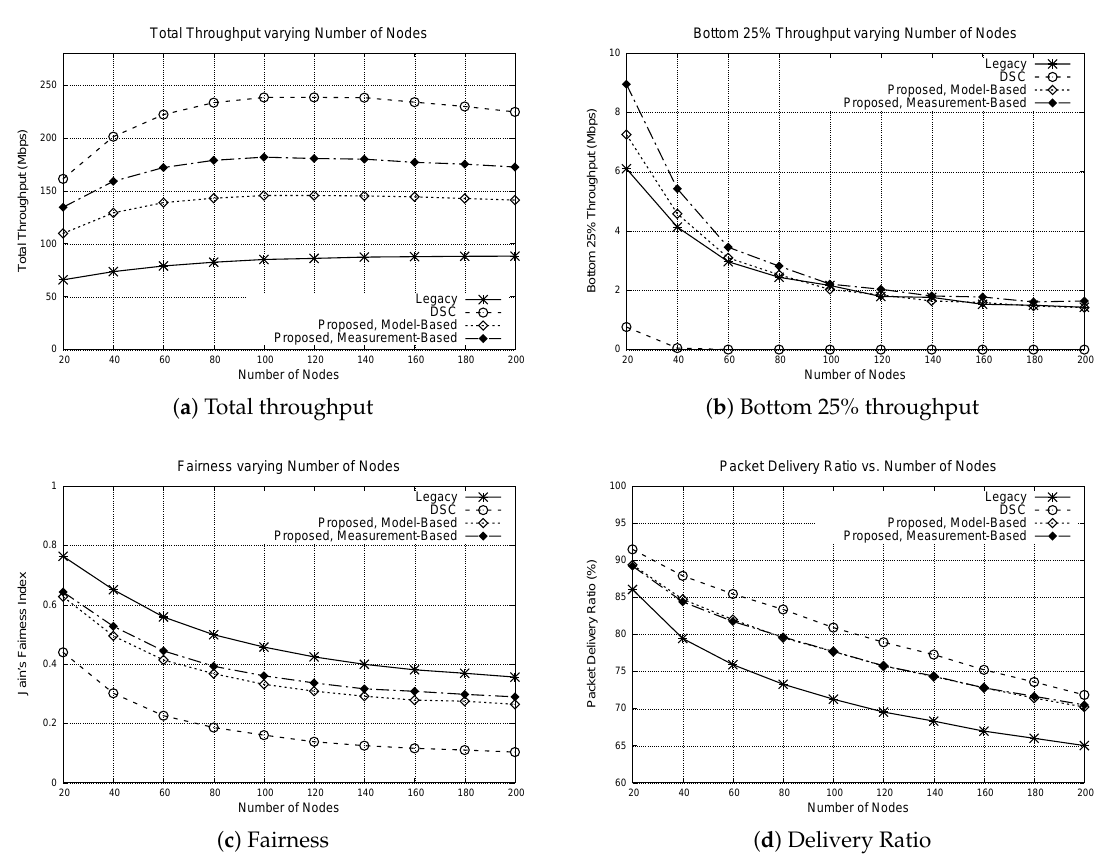
Figure 5. Performance of protocols varying number of nodes. 100 APs are placed in a grid topology, and 20 to 200 nodes are randomly deployed in the area. ( a ) total throughput, ( b ) bottom 25% throughput, ( c ) Jain’s fairness index, ( d ) packet delivery